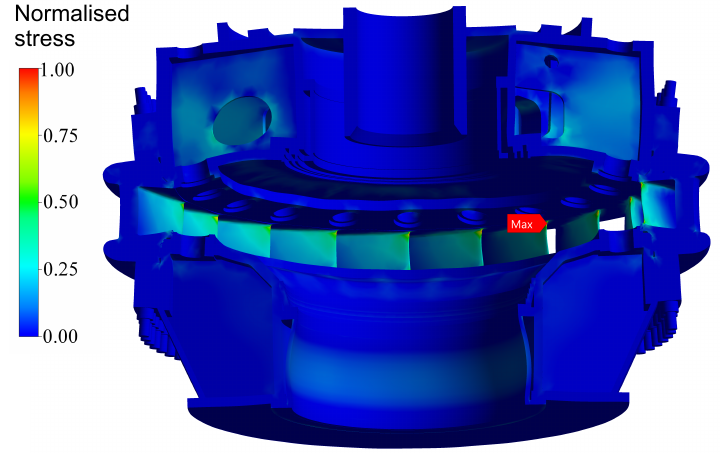
Figure 18. The stress distribution of the stationary structures. The fluid pressure on the inner surface of the stationary structures pushes the head cover upward and the bottom ring downward. The stay ring between the head cover and the bottom ring is stretched and the maximum stress occurs on the trailing edge fillet of a guide vane of the stay ring (Figure 19).